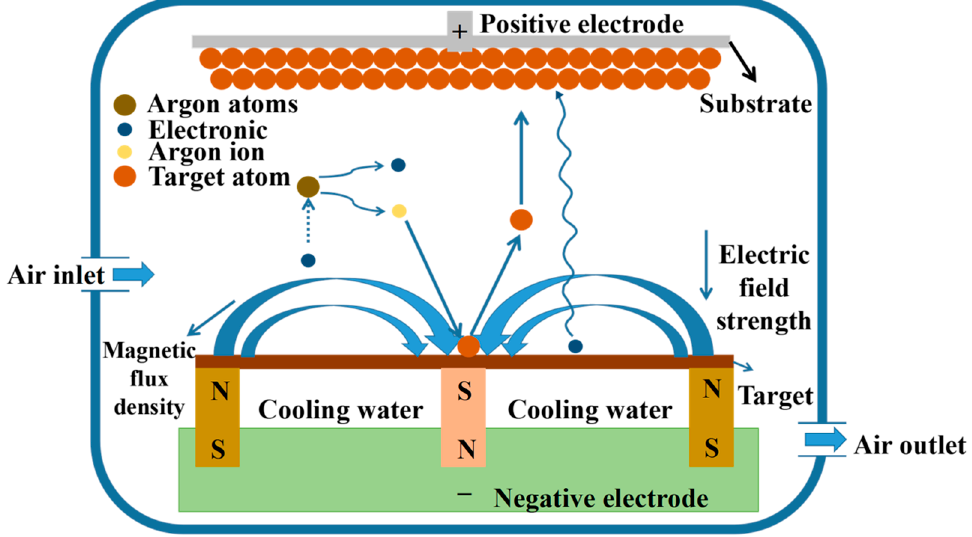
Figure 1. The schematic diagram of the physical vapor deposition magnetron sputtering process.